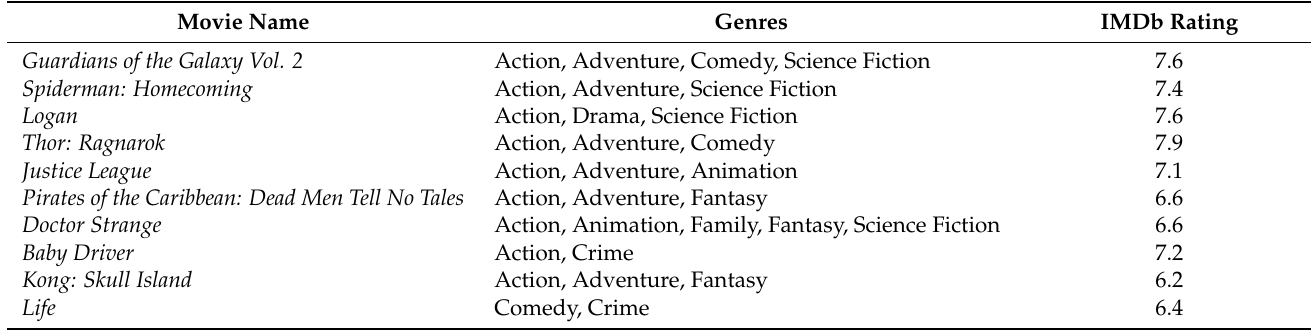
Table 18. Recommended movies for the movie Wonder Woman according to TMDb.